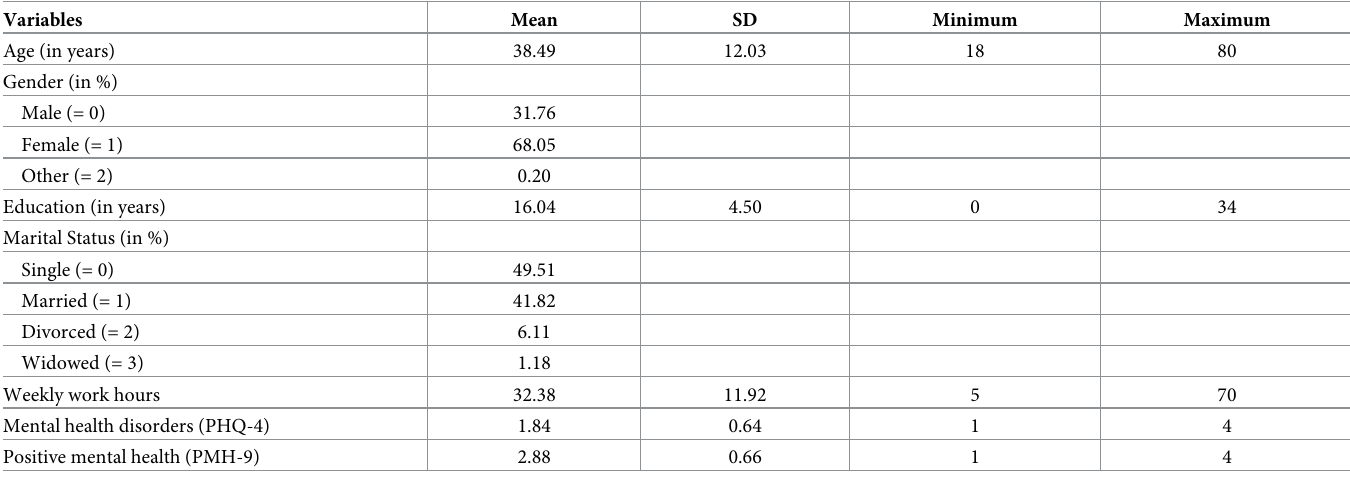
Table 1. Demographic characteristics of the